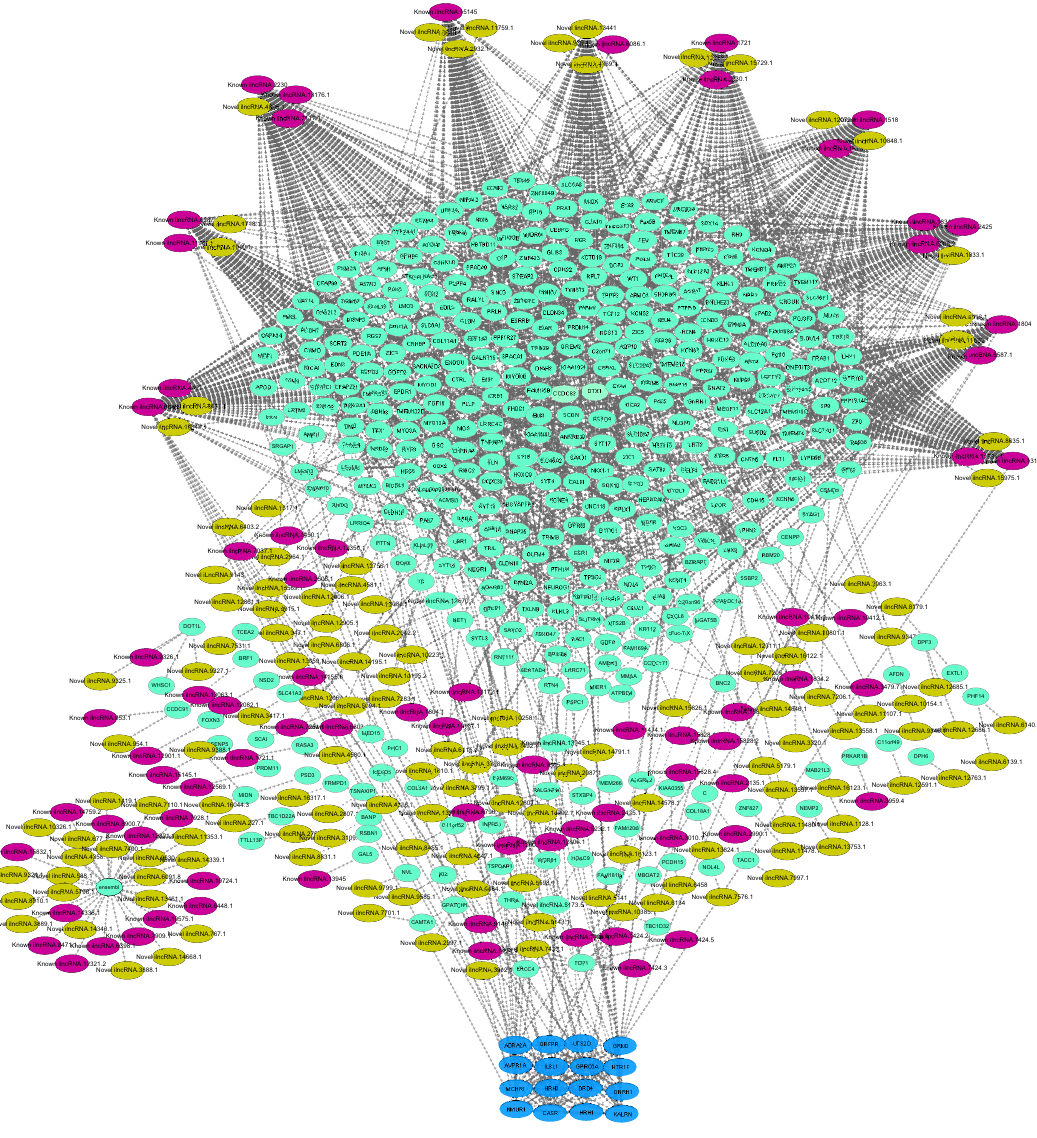
Figure 7. Final constructed network based on the known and novel ilncRNAs. Purple nodes: Known ilncRNAs, Light Olive nodes: Novel ilncRNAs, Medium Spring Green nodes: protein coding genes, light-blue nodes: predicted module (P-value = 6.147-e7).